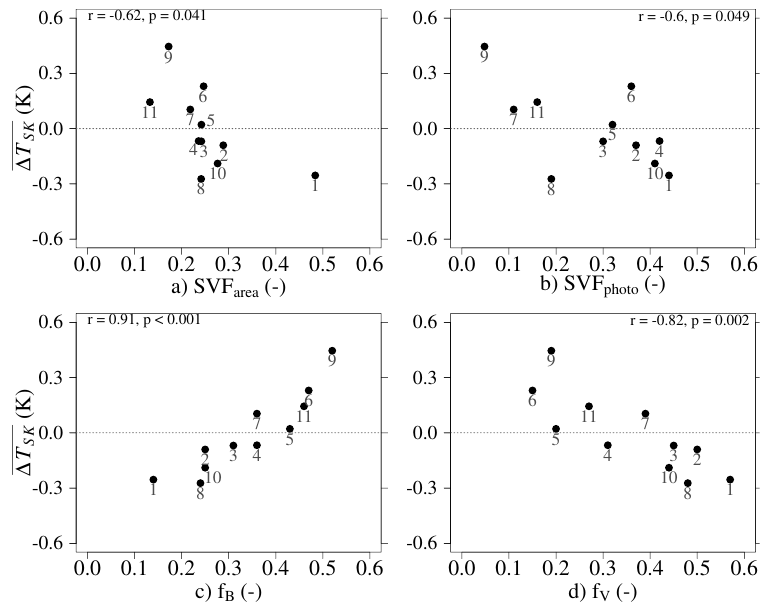
Figure 5. Night-time difference of each individual mean air temperature ( T ) to the spatial mean night-time T of all sites ( ∆ T SK ) at each measurement site within the Schillerkiez in relation to different urban morphometric parameters ( a – d ) during three nights in summer 2016 with light ( ≤ 3 m/s) east wind (23, 25, 29 June). Correlation coefficients (r) and corresponding p -values are given for each parameter. SVF area : areal sky view factor, SVF photo : sky view factor calculated from fish-eye photos, f B : building surface fraction, f V : vegetation surface fraction.